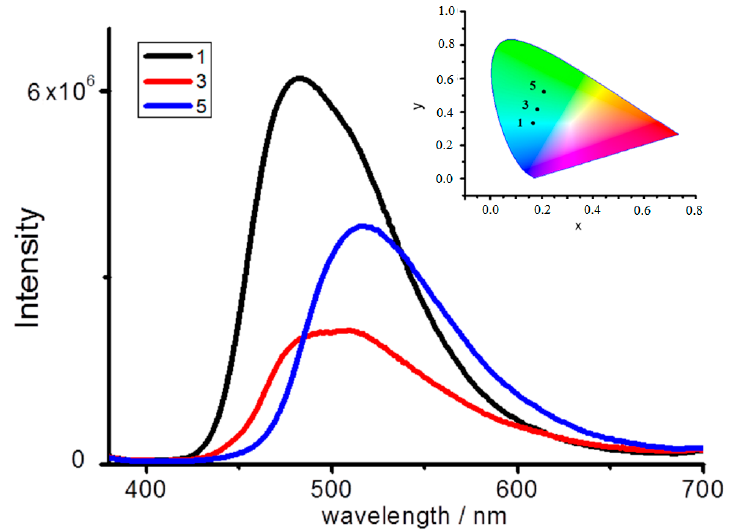
Figure 3. Emission spectra of zinc complexes in solid state and the corresponding color coordinate diagram of emission.